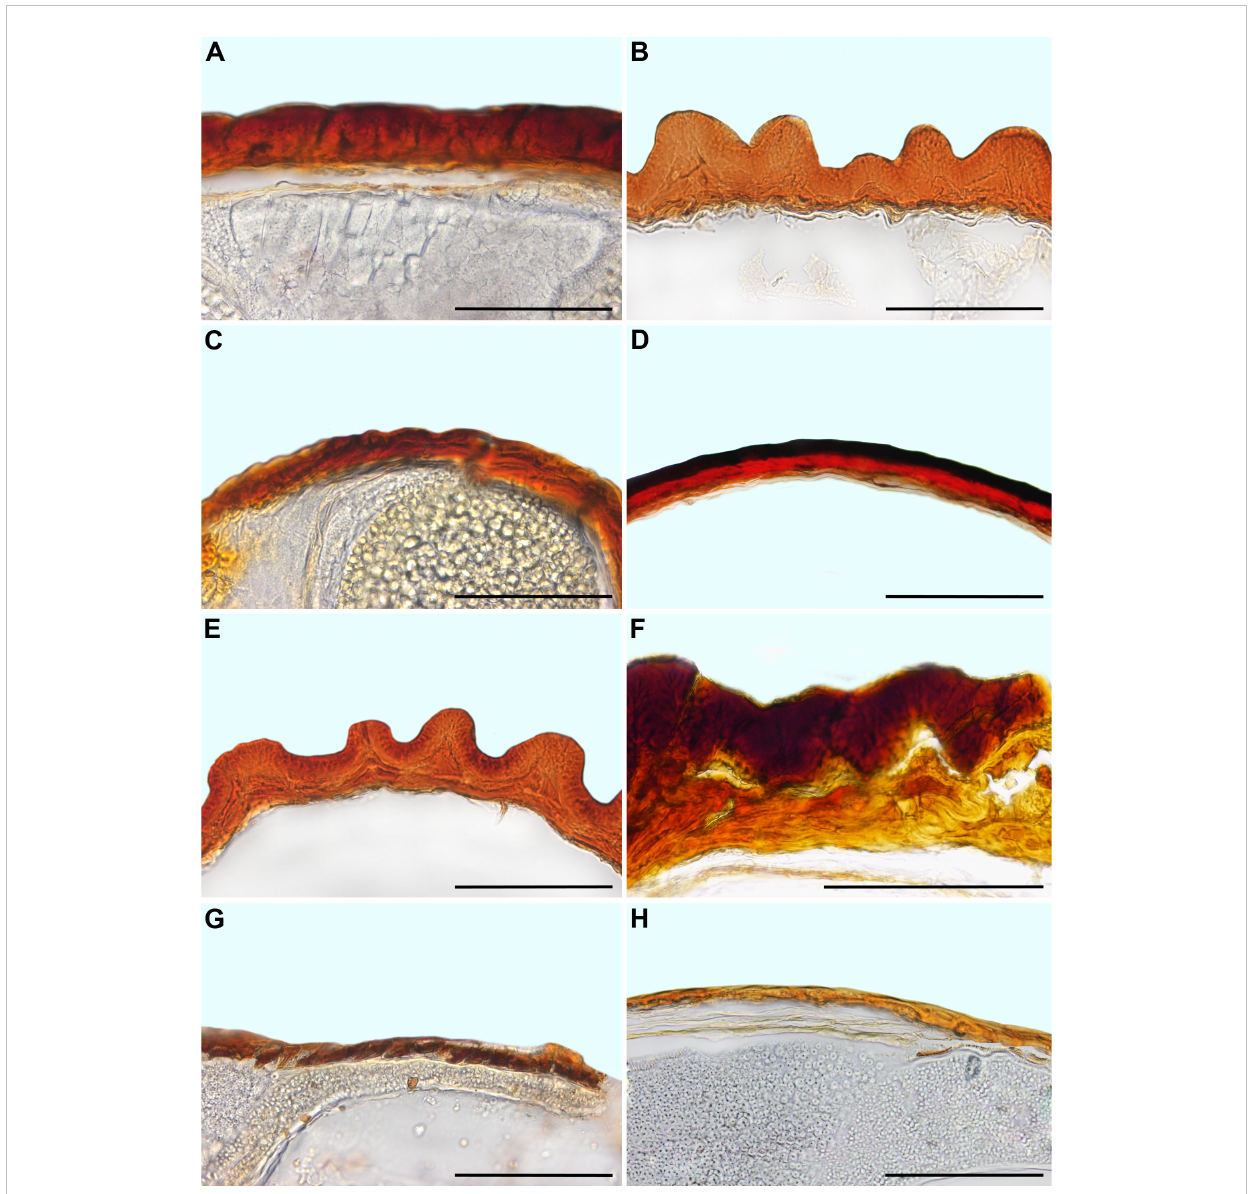
FIGURE 10 Seed coat cross-sections of selected Sesuvioideae species. (A) Sesuvium maritimum , (B) Sesuvium curassavicum , (C) Sesuvium mezianum , (D) Trianthema hereroense , (E) Trianthema crystallinum , (F) Zaleya govindia , (G) Tribulocarpus somalensis , (H) Tribulocarpus dimorphanthus . Scale bar – 100